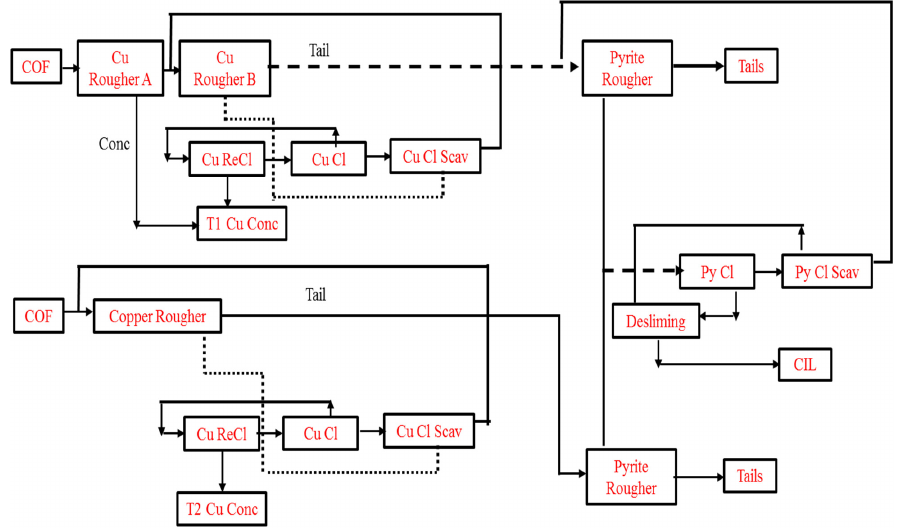
Figure 22. Pre-configuration plant flow sheet of Telfer [154].